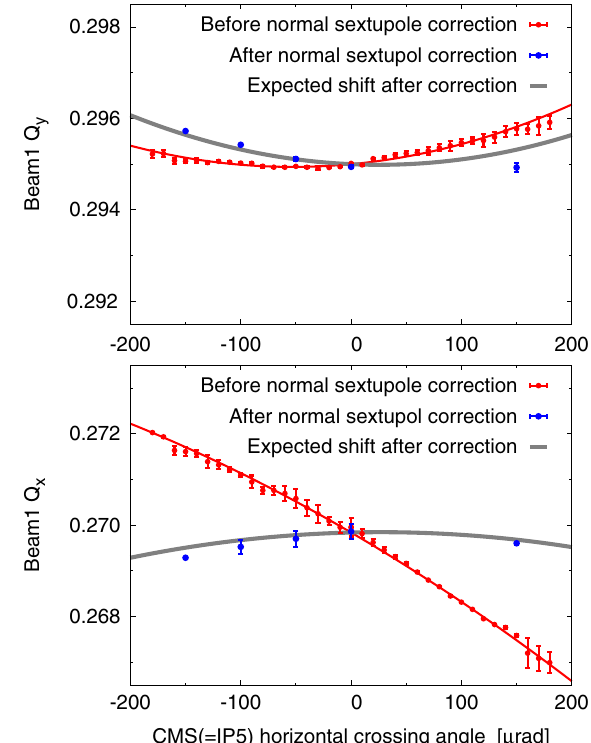
FIG. 14. Tune shift of LHC Beam 1 as a function of the horizontal crossing angle in CMS (IR5). Red data show the tune shift measured after application of normal octupole corrections, but before correction of normal sextupole. The fit to the measured data is also shown in red. Blue data corresponds to the tune shift measured after application of normal sextupole corrections. The gray line indicates the expected variation of tune after normal sextupole correction.